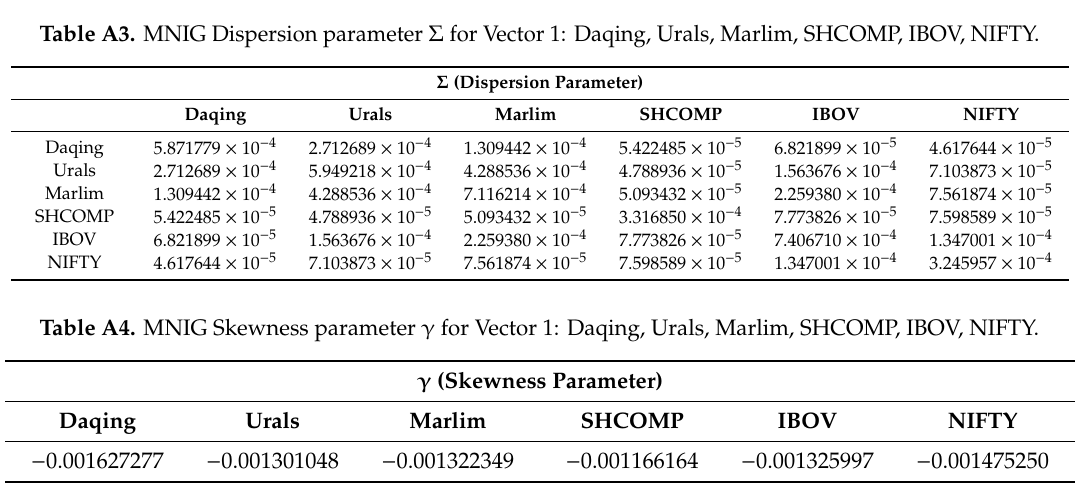
Table A5. MNIG Shape parameter α for Vector 2: Daqing, Urals, Marlim, SHCOMP, RTSI, IBOV. ¯ α (Shape Parameter)